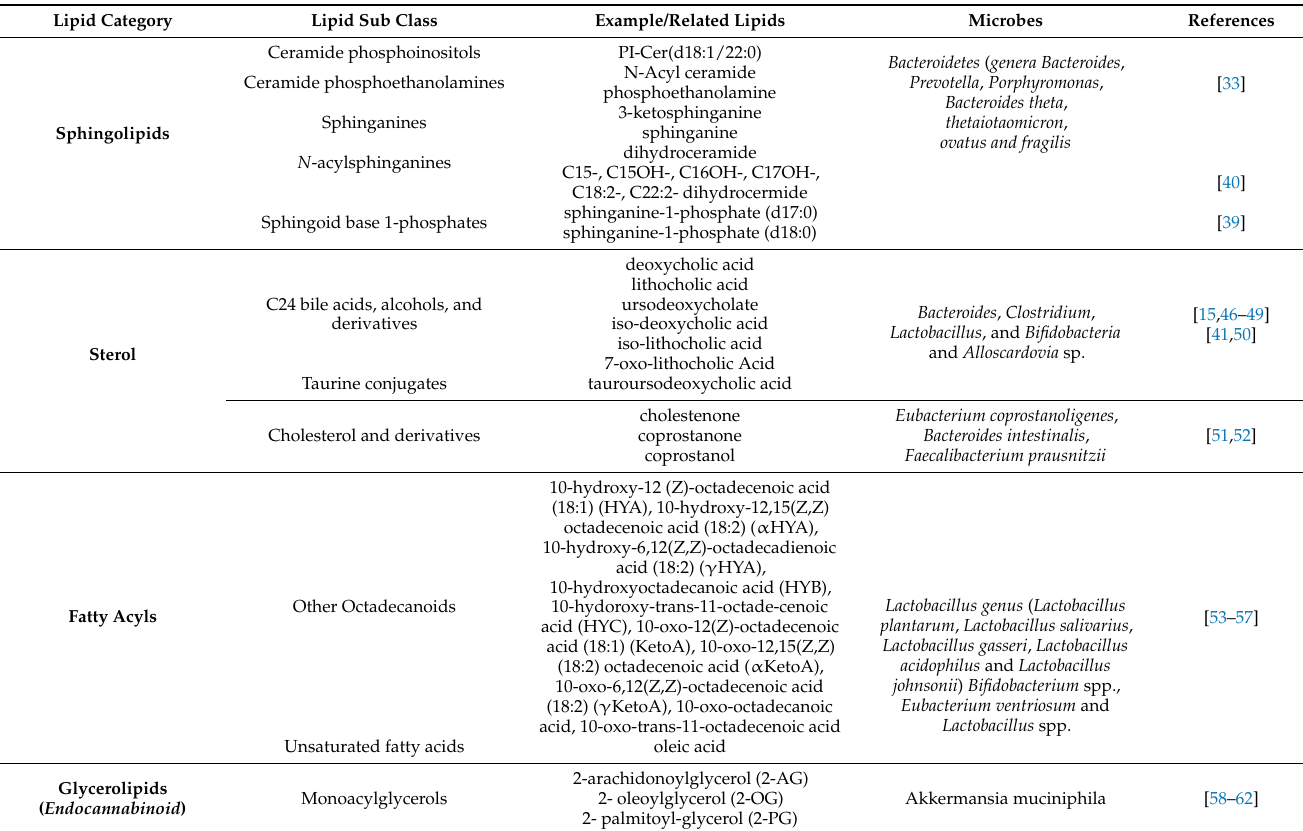
Table 1. Significant associations of bioactive lipids, gut microbiome related classes and lipid